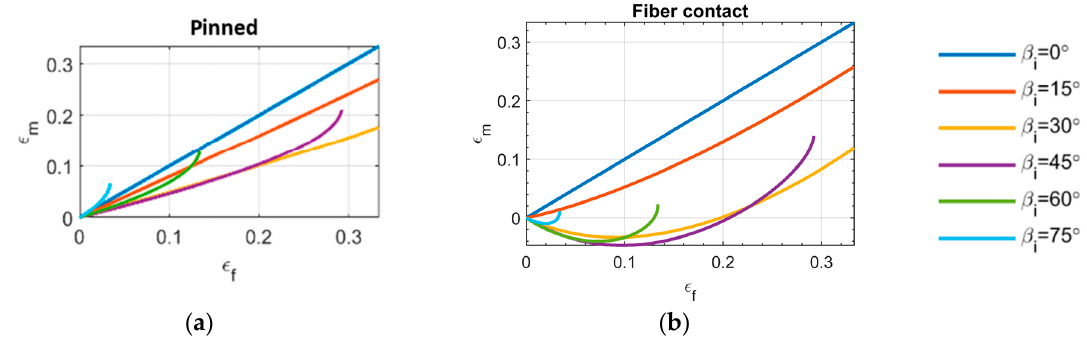
Figure 6. Muscle strain–fiber strain behavior of parallel ( β i = 0 ◦ ) and bipennate muscle bundles with pinned boundary condition ( a ) and fiber contact boundary condition ( b ). The legend shown on the far right indicates the fiber pennation angle of the muscle topology.